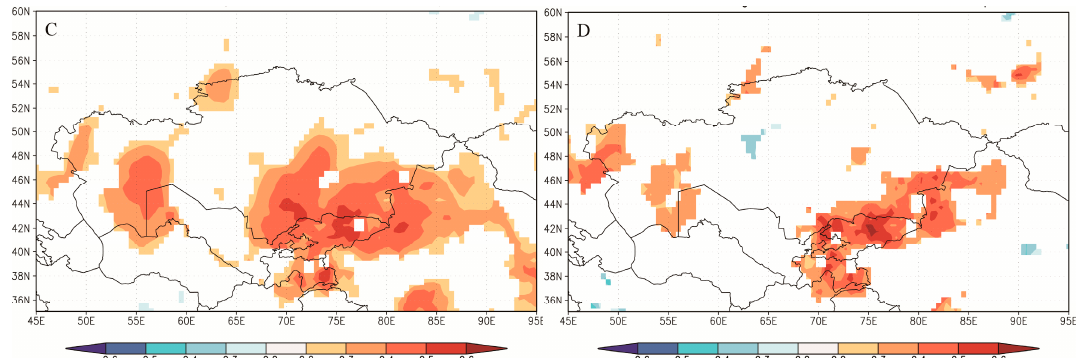
Figure 6. Spatial correlation between the reconstruction and previous July to current June grid data (1951–2012). ( A ) Precipitation data from the CRU-TS 3.22; ( B ) Precipitation data from the Global Precipitation Climatology Centre (GPCC) V7; ( C ) SPEI; ( D ) scPDSI.